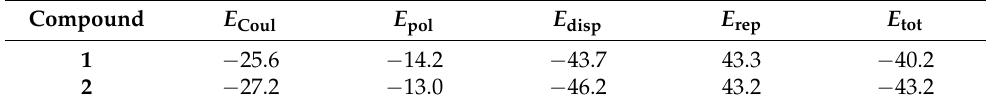
Table 4. Lattice energy for crystal structures 1 and 2 . Energy is expressed in kcal mol − 1 . Compound